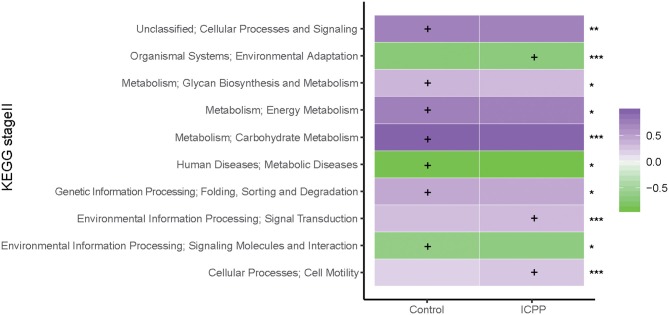
Relative abundance (log10 transformation) heat map of distinct KEGG categories in the ICPP and Control groups. Based on the functional classifications of the KEGG database, the functional categories between two groups were compared. FDR values indicated by asterisks on the right of Figure (***FDR < 0.001, **FDR < 0.01, *FDR < 0.05). The enrichment of functional category is indicated by cross.